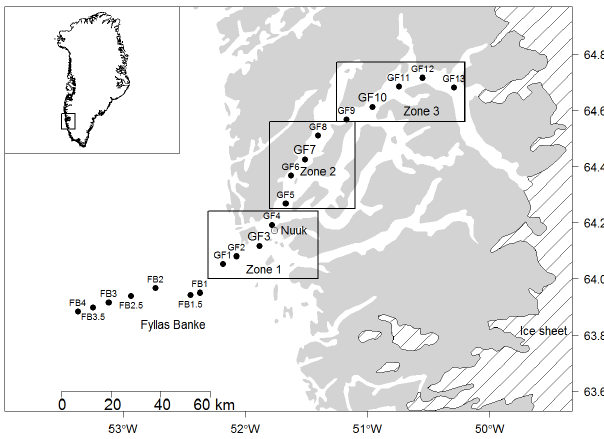
Figure 1. Map of the Godthåbsfjord system with the sampling sta- tions in the fjord system and at Fyllas Banke (SW Greenland). The fjord system is divided into three zones, indicated by boxes. Mete- orological data are available from a station in